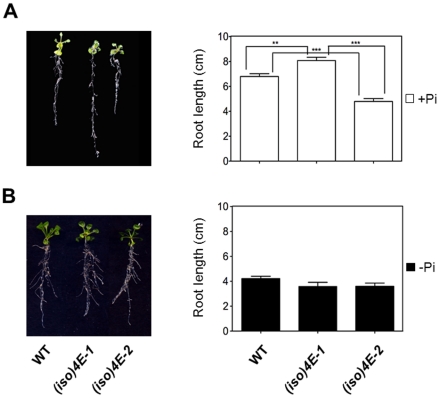
The eIF(iso)4E absence or overexpression is associated with root length alteration in Arabidopsis thaliana.Plants from wild type Col-0 [WT], knockout [(iso)4E-1] and overexpressing [(iso)4E-2] lines were grown on Gamborg's B5 for 15 days and then transferred for 10 days to Hoagland medium supplemented with (+Pi) or without (−Pi) phosphate in squared Petri dishes placed vertically in a growth chamber. Data are shown as the mean of 9 biological replicates with 3 technical replicates of each one, with error bars indicating the standard error. One way ANOVA with Tukey's Multiple Comparison Test with a p value<0.05 was used. Significant differences in primary root length between the 3 lines are indicated by asterisks (**, p<0.01; ***, p<0.001). A. In the presence of phosphate, the (iso)4E-1 primary root was significantly larger than WT (p<0.01), whereas (iso)4E-2 was significantly shorter than WT and (iso)4E-1 (p<0.001). B. After 10 days under phosphate deficiency, the primary root of all three lines was significantly shorter than the correspondent to plants grown in control conditions and did not display significant differences between lines.